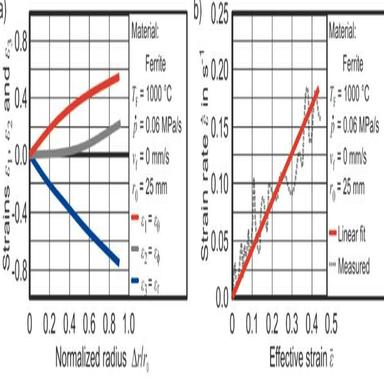
a) Resulting strains (εθ, εϕ and εr) in the pole with increasing normalized radius Δr/r and b) resulting strain rate ˙ ε with increasing effective strain ε.